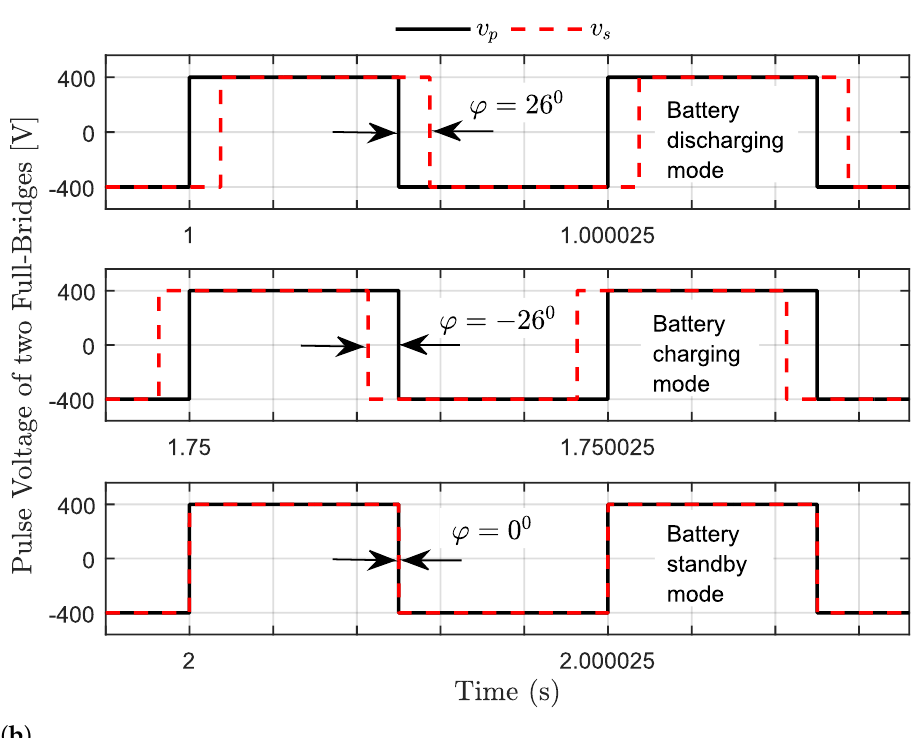
Figure 12. Simulated Case 2: ( a ) SoC of the battery, and phase–shift control; ( b ) Pulse voltage of two Full–Bridges, v p and v s